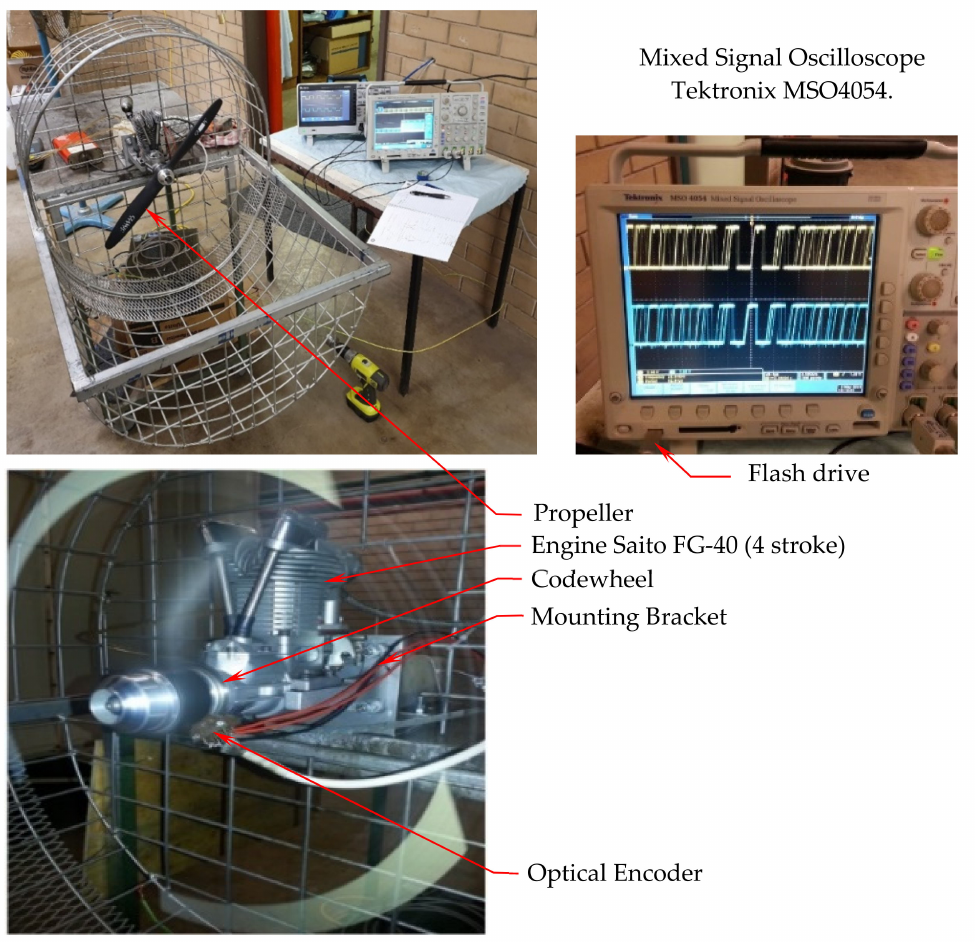
Figure 6. Engine test